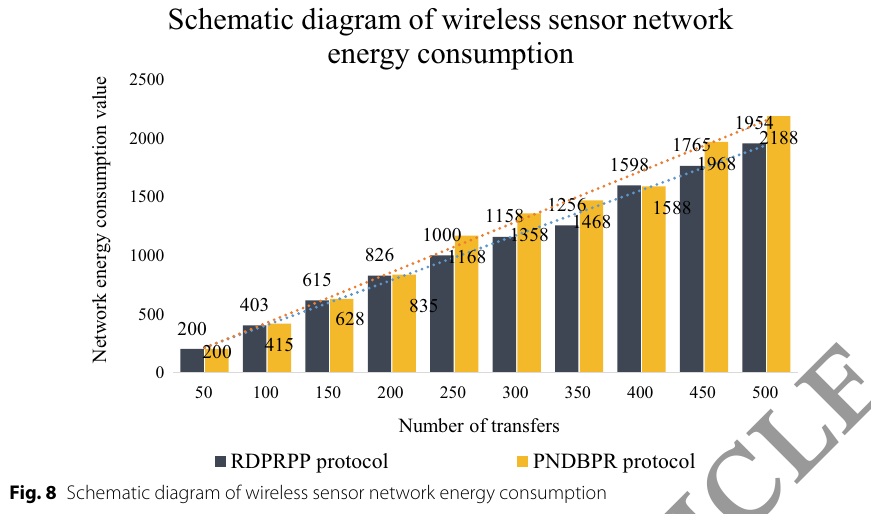
Table 2 Number of sensing nodes N and network energy consumption expression Perception node OSERQ